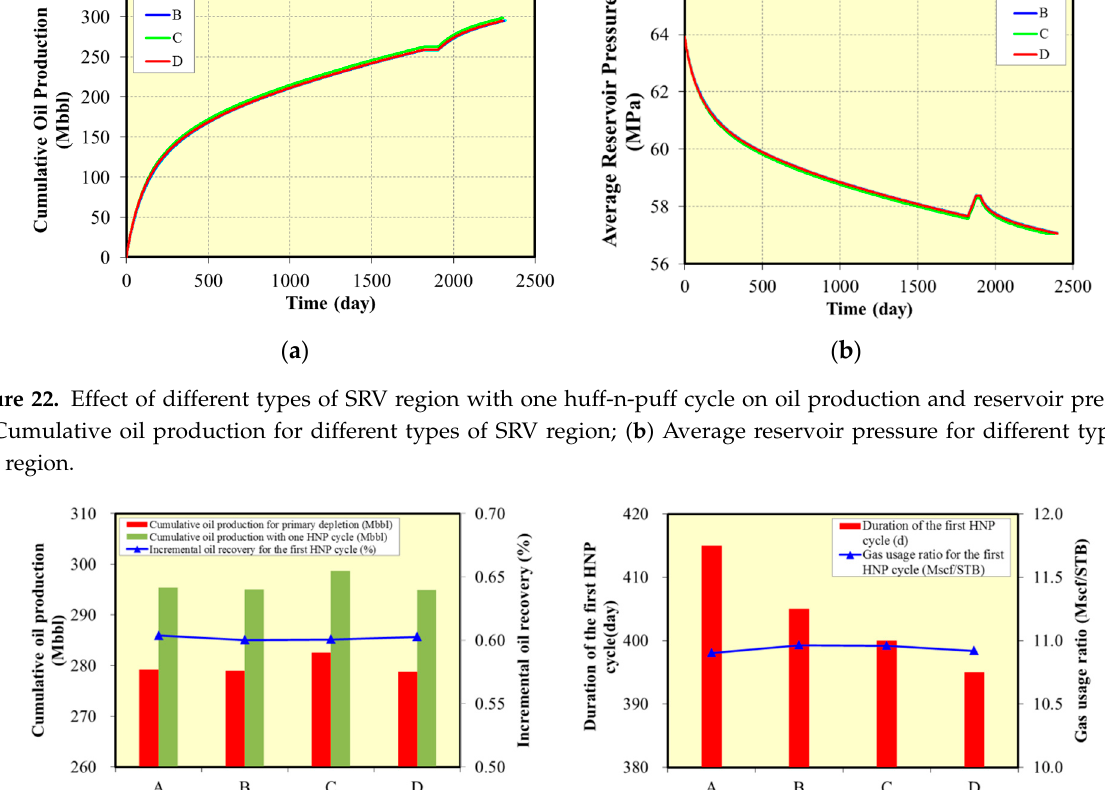
Cumulative oil production with one